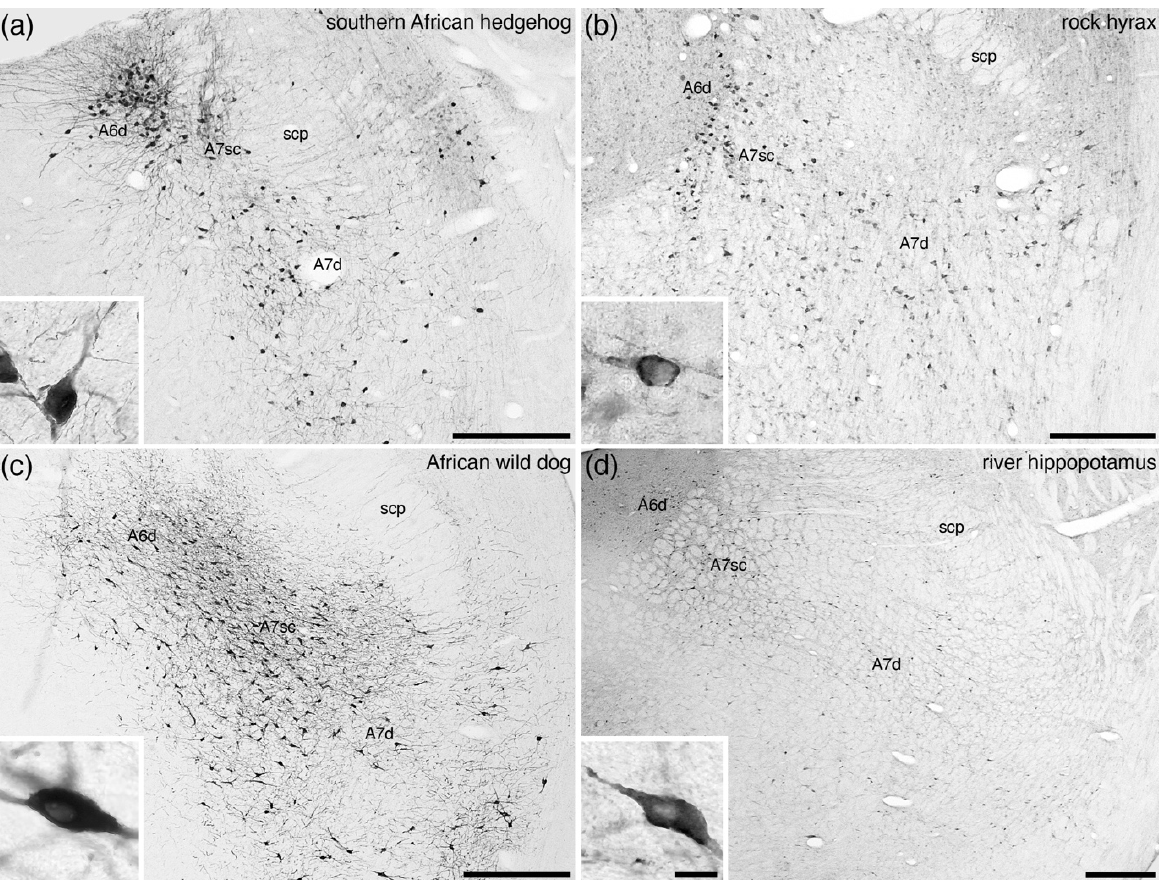
Figure 10. Low-magnification photomicrographs of the subcoeruleus, or A7, region revealed with immunostaining for tyrosine hydroxylase in four mammalian species belonging to the Laurasiatheria superorder of Eutherian mammals, including ( a ) the southern African hedgehog ( Atelerix frontalis ) [19], ( b ) rock hyrax ( Procavia capensis ) [17], ( c ) the African wild dog ( Lycaon pictus ) [pers. obs.], and ( d ) the river hippopotamus ( Hippopotamus amphibius ) [37]. Note the presence of the compact portion of the subcoeruleus ( A7sc ) in the dorsal aspect of the tegmentum, with scattered more widely distrib- uted neurons throughout the parvicellular reticular nucleus forming the diffuse portion of the subcoeruleus ( A7d ). Insets in each image show a high-magnification image of the neurons that form the A7d in each species. In all images, dorsal is to the top and medial to the left. Scale bars in ( a , b ) = 500 µm and apply to the respective images. Scale bars in ( c , d ) = 1 mm and apply to the respective images. Scale bar in inset d = 25 µm and applies to all insets. scp —superior cerebellar peduncle.